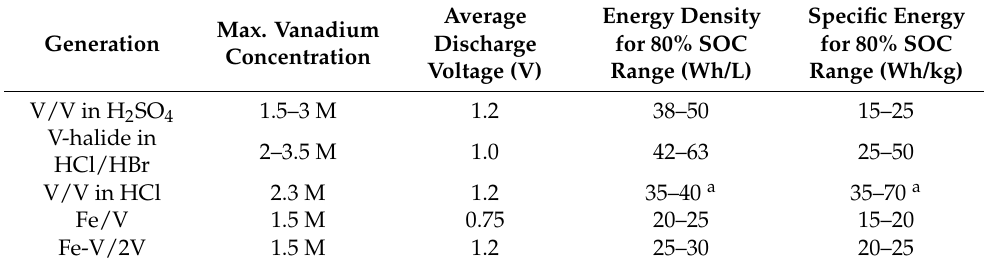
Table 2. Main characteristics of different generations of VRFBs